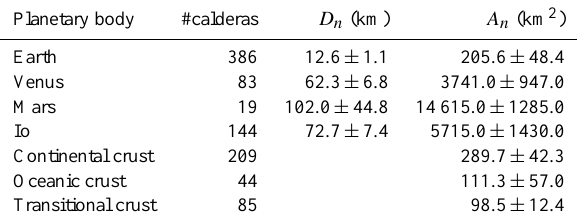
Table 1. Summary of the data used for the planetary caldera anal- ysis. D n is the mean diameter and A n is the mean caldera area computed from the minimum and maximum diameters assuming an elliptic shape for each planetary body, except for the Earth where some caldera areas are estimated using the actual shape (Geyer and Marti, 2008). The errors are given at 95% confidence intervals.